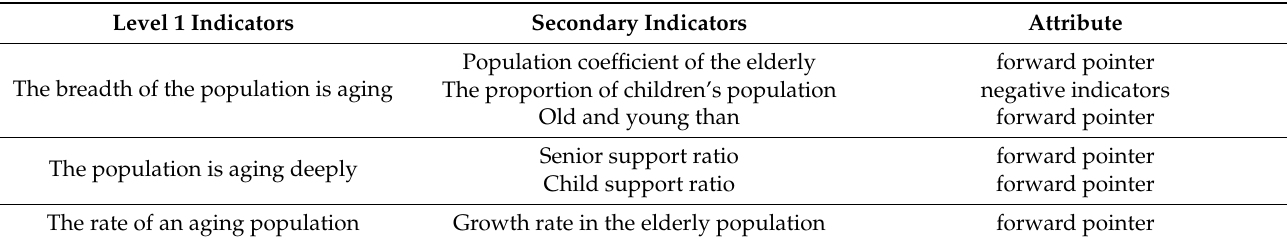
Table 1. Index system and attributes of population